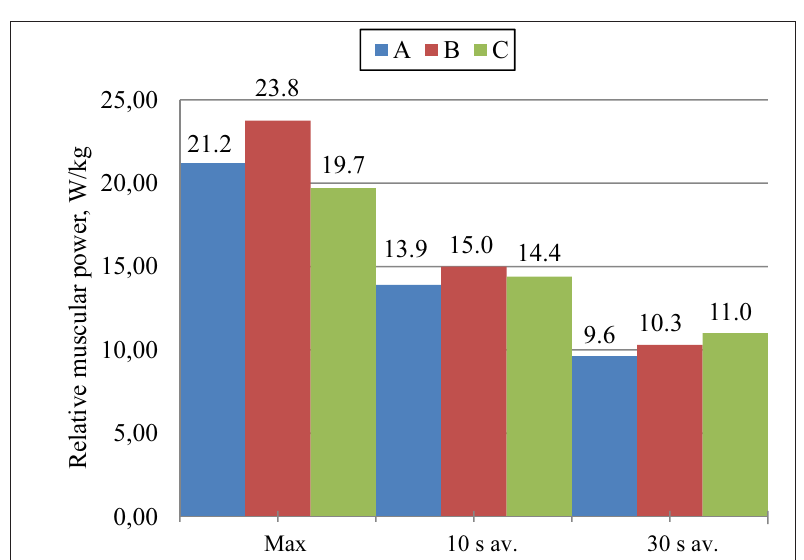
Figure 3. Comparative characteristics of different specialization female cyclists’ indices of AAMP and mixed anaerobic alactate glycolytic relative muscular power at various energy producing zones muscular power indices are insignificantly lower than analogical indices of one of the best World track sprinters and glycolytic capacity is lower than that track of track sprinter and pursuit cyclist. 3. Functional capacity of blood circulation system of elite cyclist (C), whose part of energy during competition period is produced in aerobic way, is the highest and these indices of our investigated BMX cyclist are slightly lower than aerobic capacity of cyclist C.